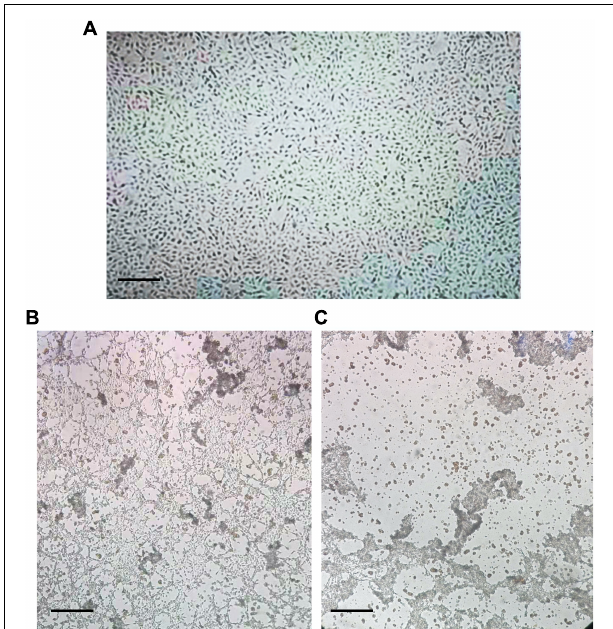
FIGURE 2 | Morphological observation of the cytopathic effect (CPE) of bovine rotavirus (BRV) in MA-104 cells. (A) Uninfected MA-104 cells with an intact cell sheet. (B) CPE of infected MA-104 cells at 48 h post-infection (hpi) with BRV. Partial cells in the cell sheet became lysed and were detached from the growth surface. (C) CPE of infected MA-104 cells at 72 hpi. The cells showed complete lysis and detachment from the growth surface. Bar indicates × 4